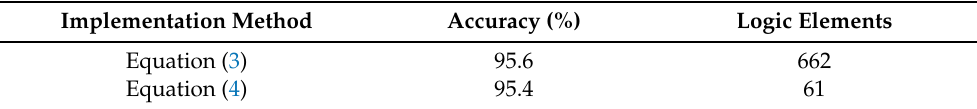
Table 1. Accuracy according to the absolute value calculation method and logic elements usage of absolute value calculation